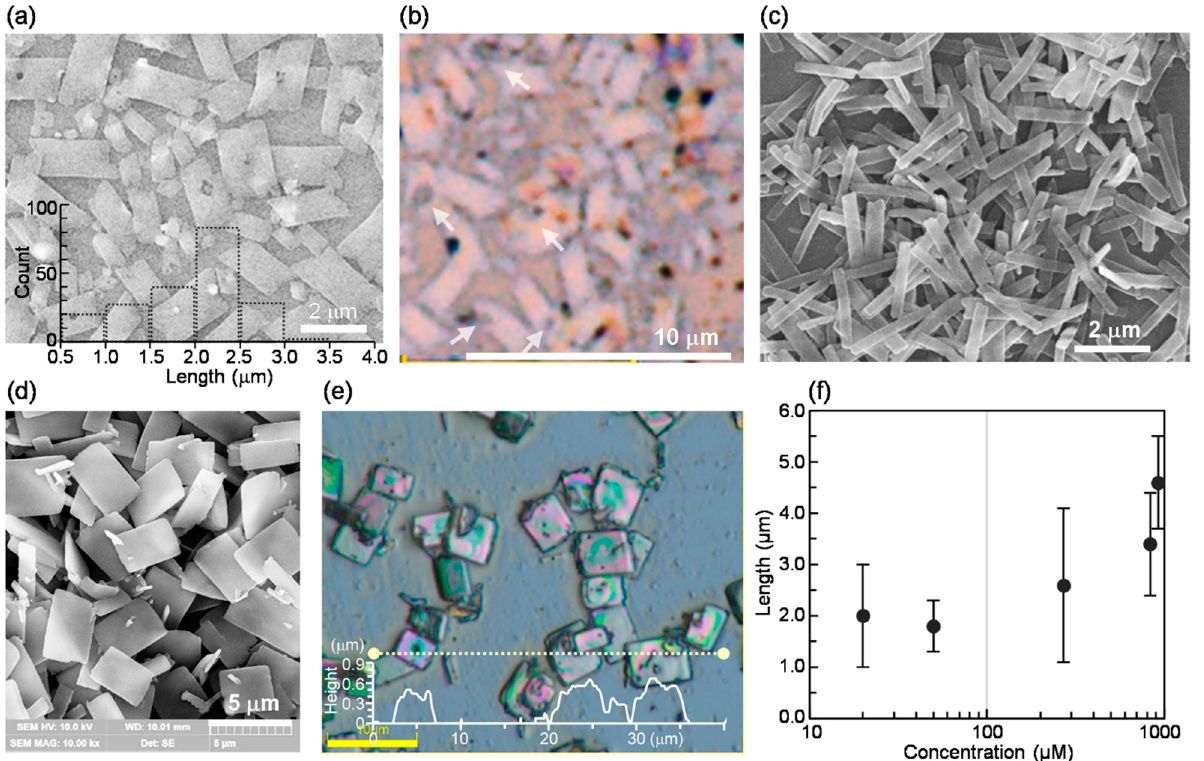
Figure 3. SEM and OM images of rectangular sheet ‐ like structures obtained from ( a , b ) 20 μ M DMF ‐ H 2 O (1/3, v / v ), ( c ) 50 μ M DMF ‐ H 2 O (1/1, v / v ), ( d , e ) 920 μ M DMF ‐ H 2 O (6/0.5, v / v ) turbid mixtures. ( f ) Changes in the lengths of sheet ‐ like structures as a function of the DMF ‐ H 2 O mixture concentration (counting 200 aggregates). The holes and tears are marked with white arrows in ( b ).